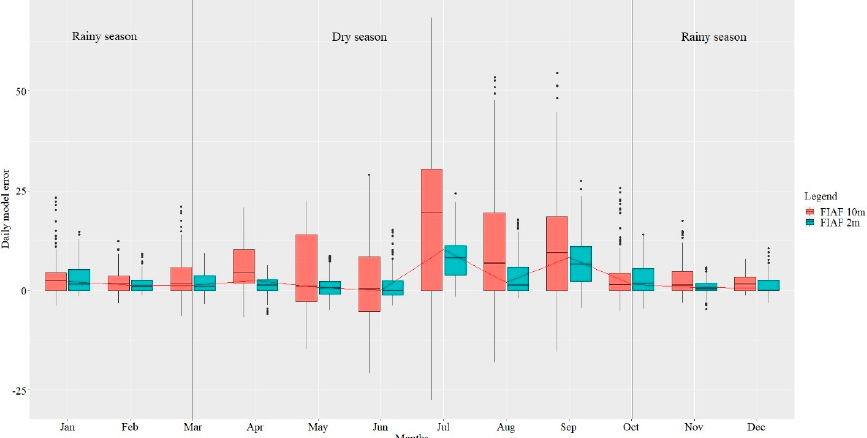
were concentrated mainly in the rainy season for both levels (2 m and 10 m). The smallest errors found throughout the series were found with the 2 m level FIAF model (Figure 5).